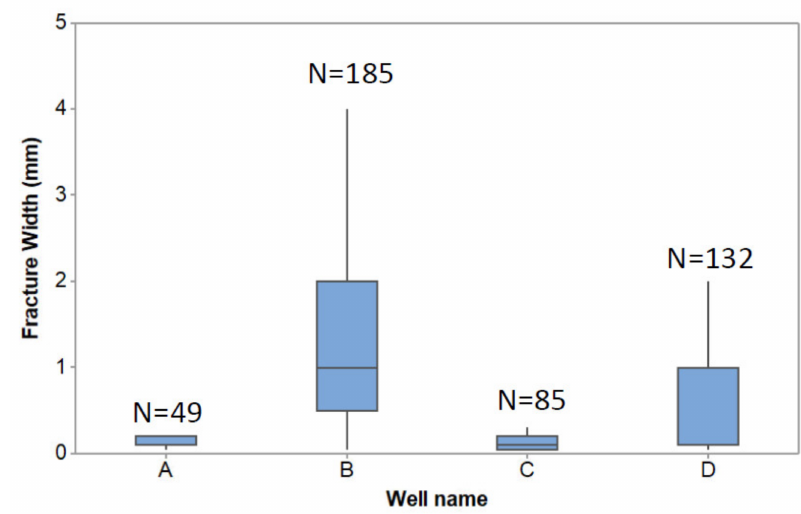
Figure 8. Box plot of fracture widths for four different wells using NMQP data.